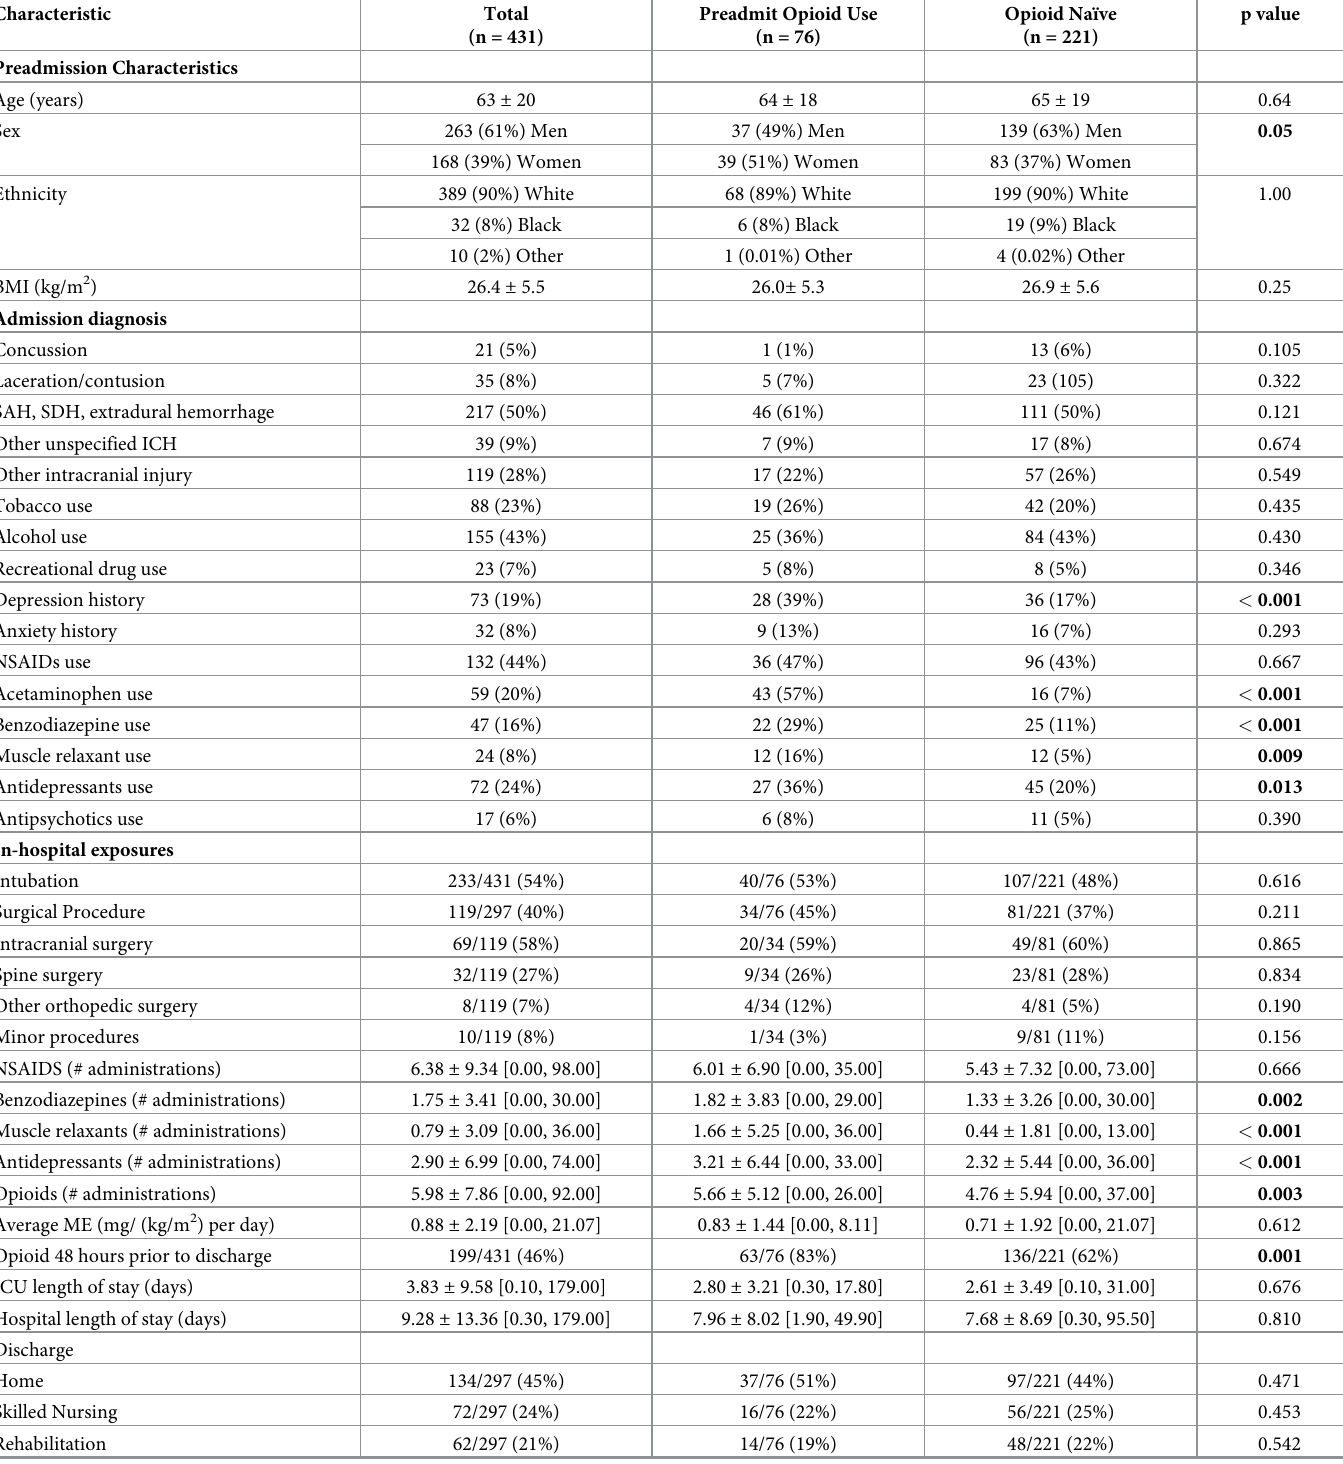
Table 1. Comparison of patient demographics, preadmission characteristics and in-hospital exposures between preadmission opioid users and opioid na ï ve patients.